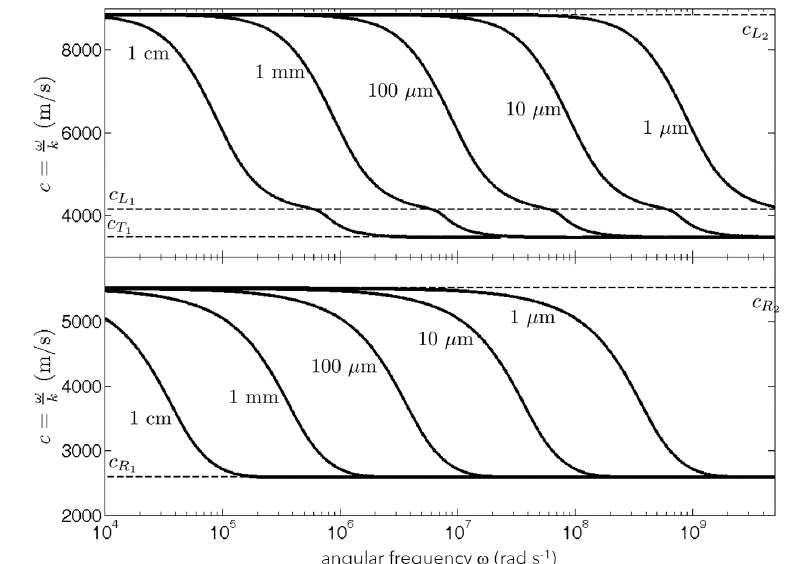
Figure 2. Illustration of Rayleigh (bottom Figure) and Sezawa (top Figure) wave phase velocity dispersion [27,38,39] for a coating-substrate configuration, for different thicknesses of the coating (1, 10, 100, 1000, 10000 micron). The used material parameters are ( c L 1 = 4157 m/s, c T 1 = 3473 m/s, ρ 1 = 8100 kg/m 3 , c L 2 = 8852 m/s, c T 2 = 6368 m/s and ρ 2 = 3650 kg/m 3 ). The Rayleigh wave velocity saturates at the value of pure coating c R 1 and substrate c R 2 material in the high and low frequency limit, respectively. The Sezawa wave velocity decreases from the longitudinal velocity of the substrate c L 2 in the low frequency range till the longitudinal velocity of the coating c L 1 , and then further decreases and saturates at the shear velocity of the coating c T 1